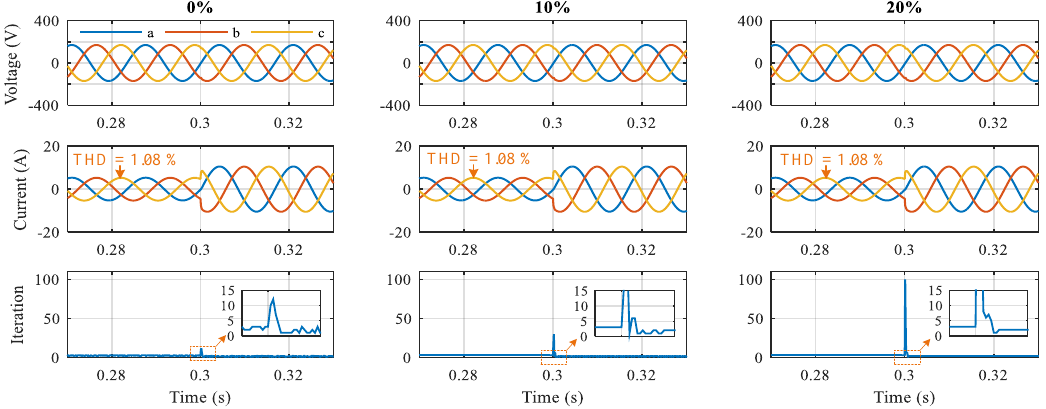
Figure 7. The effect of uncertain parameters on the control performance.